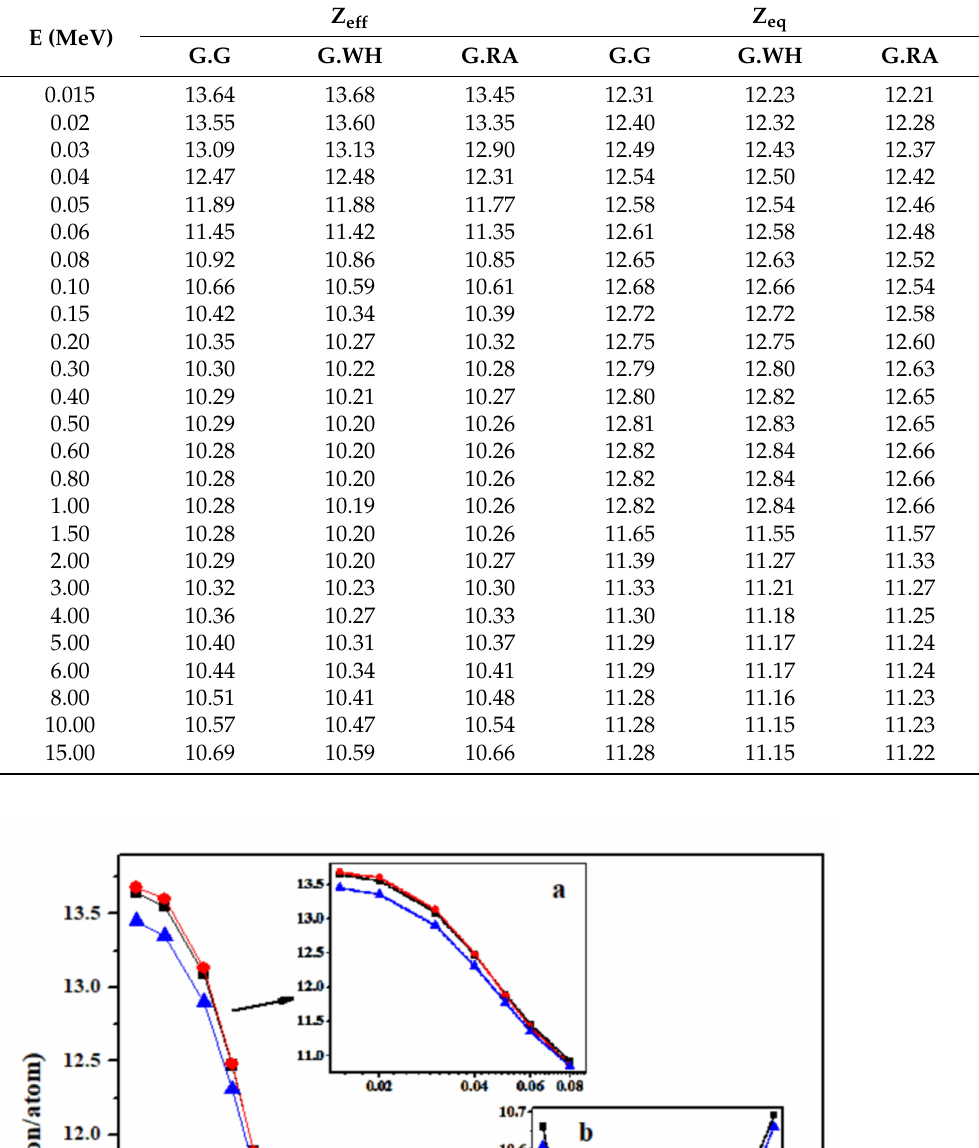
Table 4. Effective atomic number (Z eff ) and equivalent atomic number (Z eq ) for the granite sample.